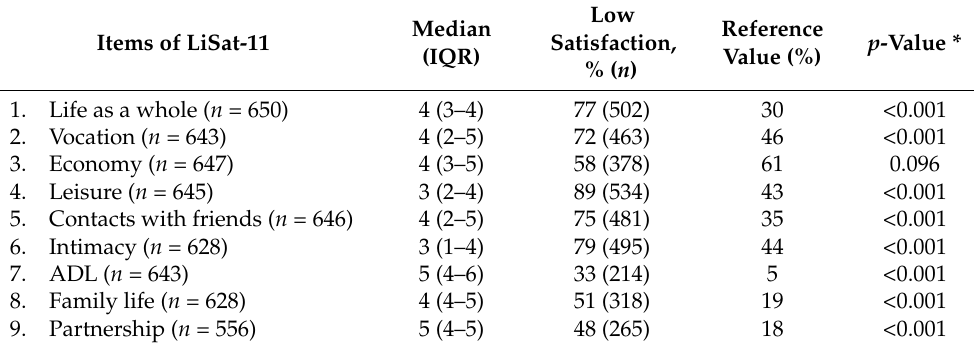
Table 3. Life satisfaction and LiSat-11 scores in persons with